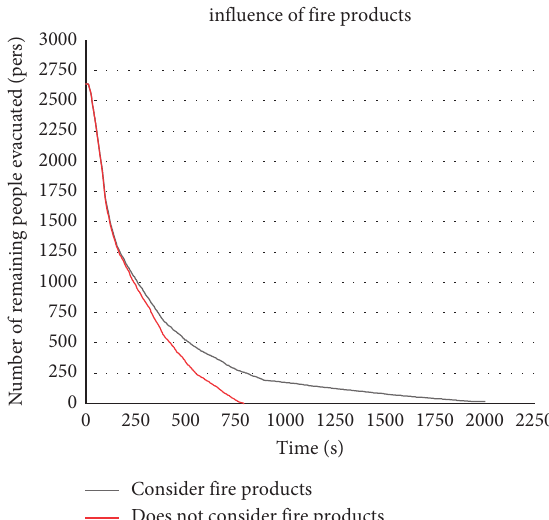
Figure 25: Pedestrians evacuation under the influence of fire